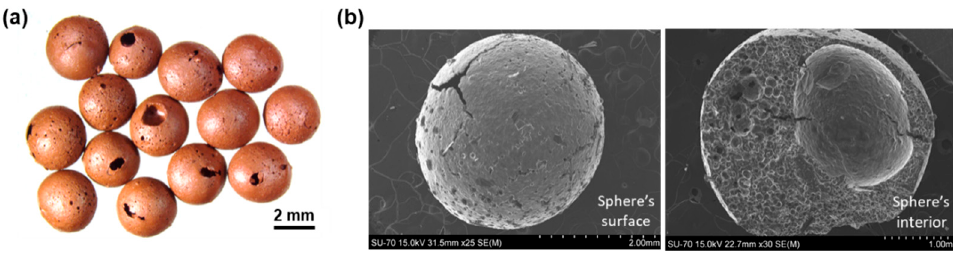
Figure 2. ( a ) Optical microscopy and ( b ) SEM micrographs of the red mud-based geopolymer spheres.